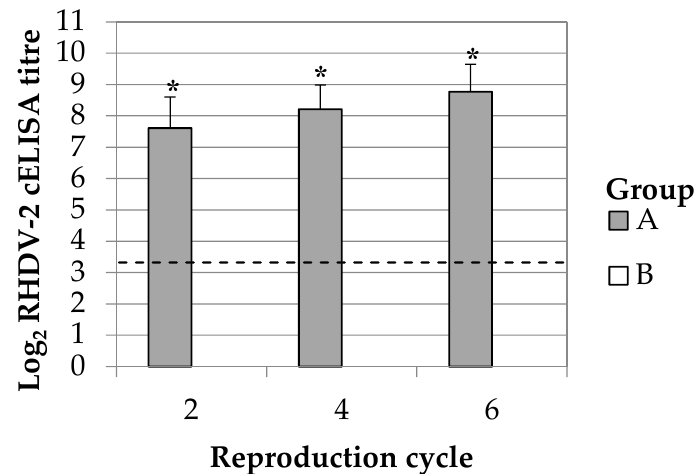
Figure 2. RHDV-2 antibody immunity in rabbit kits of 2 days of life. Results are represented as average and standard deviation. Breeding does were vaccinated either with ERAVAC ® (Group A) or inoculated with PBS (Group B). The slashed line indicates the cut-off of the assay (3.32 Log 2 cELISA titre). Asterisks (*) indicate statistically significant differences between groups (Mann-Whitney U test, p < 0.05).